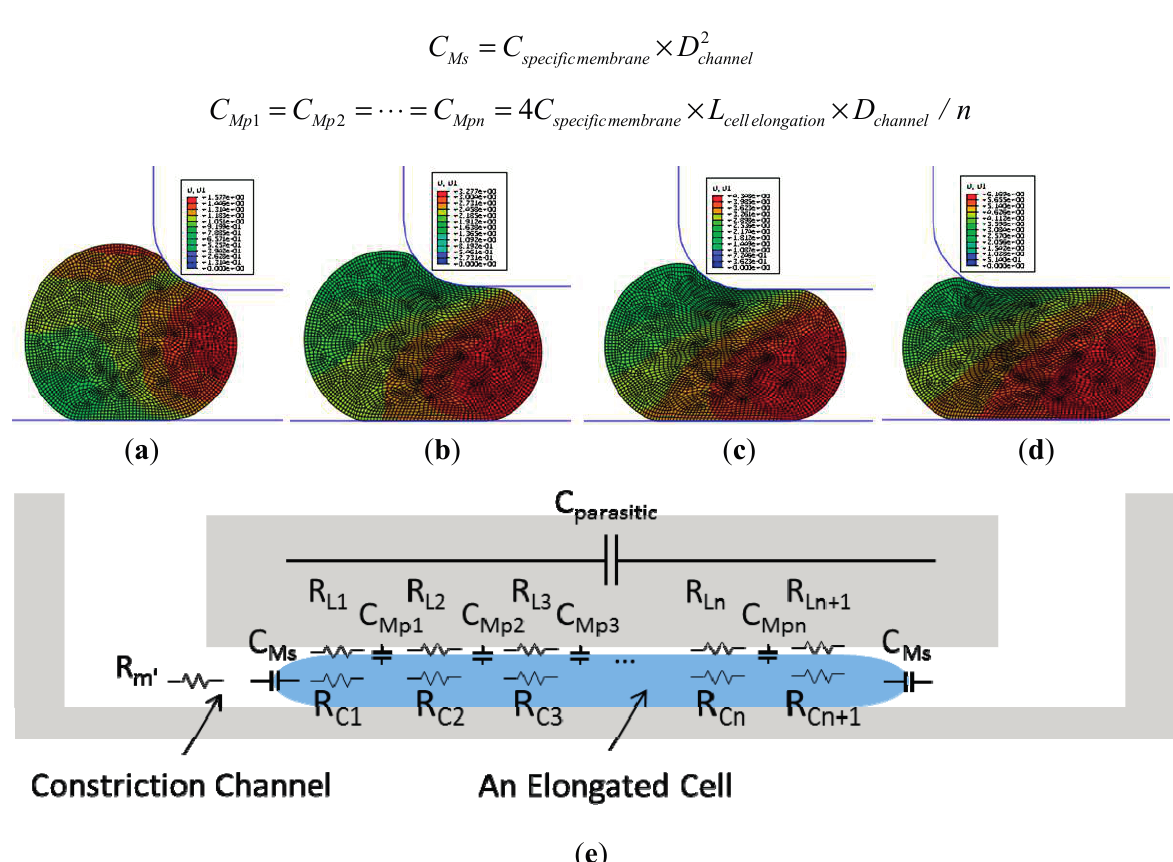
Figure 2. ( a – d ) Numerical simulations to model the cellular entry process including ( a ) initial jump into the channel; ( b , c ) cellular creep response and ( d ) creep response termination at the transitional position; ( e ) The proposed equivalent circuit model for a travelling cell within the constriction channel where C Ms , C Mp 1 , …, C Mpn and R C 1 , …, R Cn+ 1 represent distributed membrane capacitance and cytoplasm resistance with n divisions along the cell elongation direction. Note that R L 1 , R L 2 , …, R Ln , R Ln+ 1 represent distributed leakage resistors, indicating the sealing properties of deformed cells with constriction channel